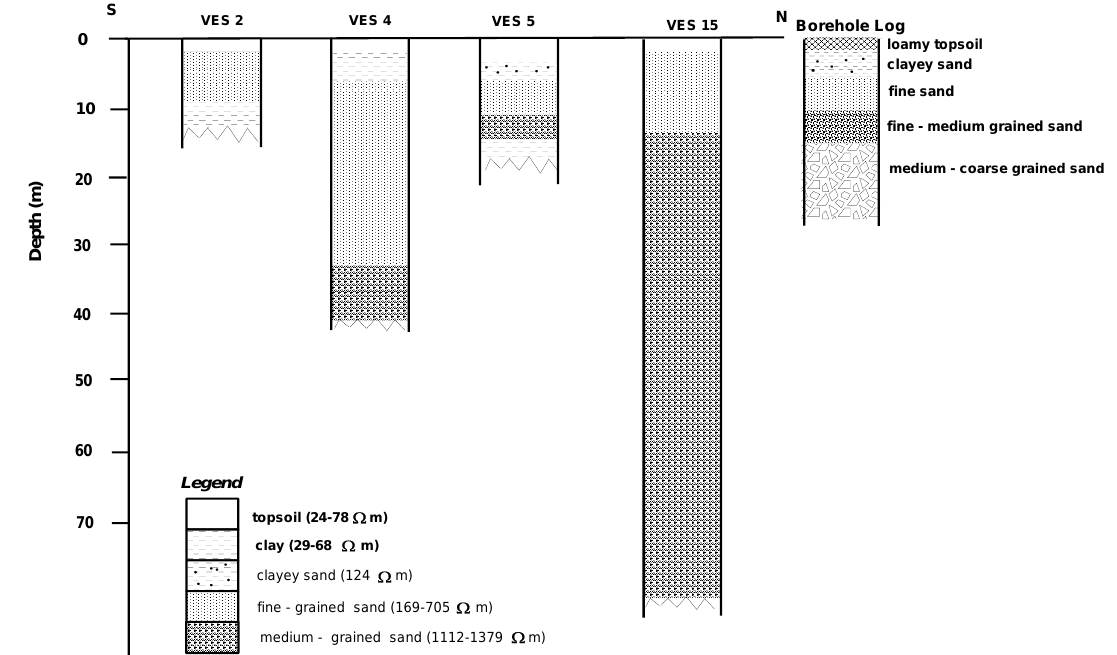
Figure 3. Geoelectric section showing vertical electrical soundings (VES) points along the direction north–south.